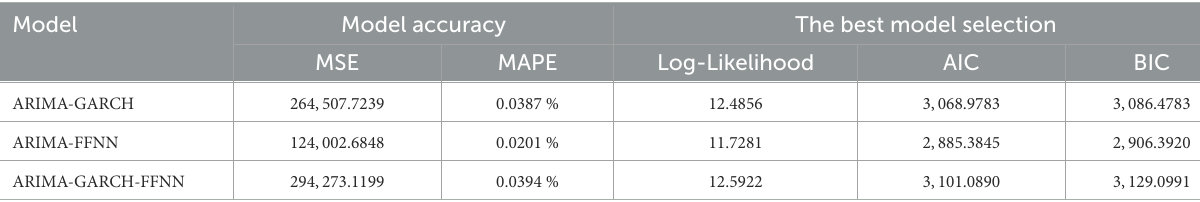
TABLE 13 Comparison of the ARIMA model with GARCH, FFNN, and GARCH–FFNN using model accuracy and the best model selection.